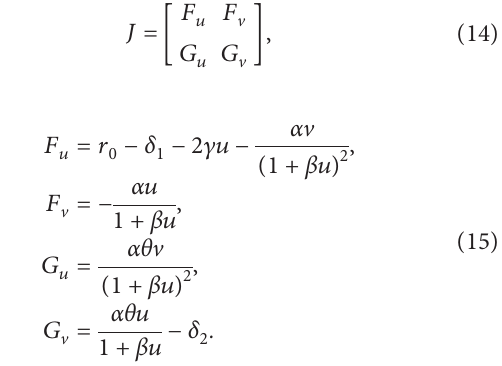
� 0 . 05. (a) For different β ; (b) for different α ; (c) for different values of r 2